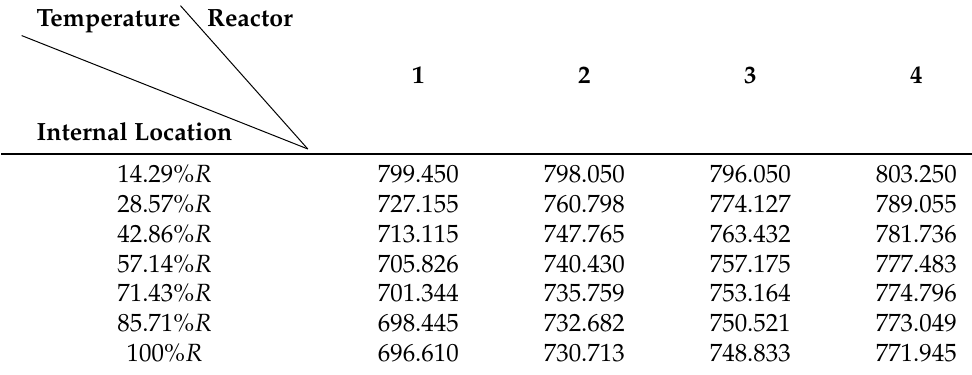
Table 1. The distribution of reactor temperature after dynamic simulation of the continuous model.